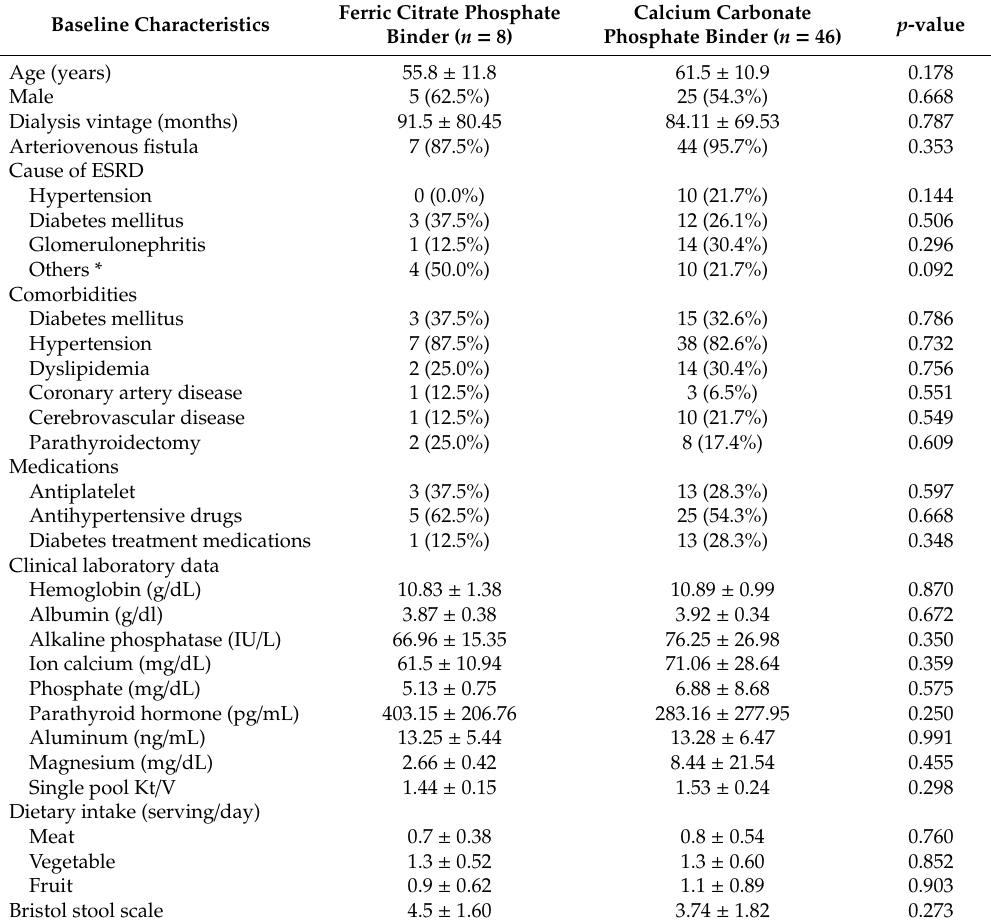
Table 1. Baseline characteristics of hemodialysis patients with di ff erent phosphate binders